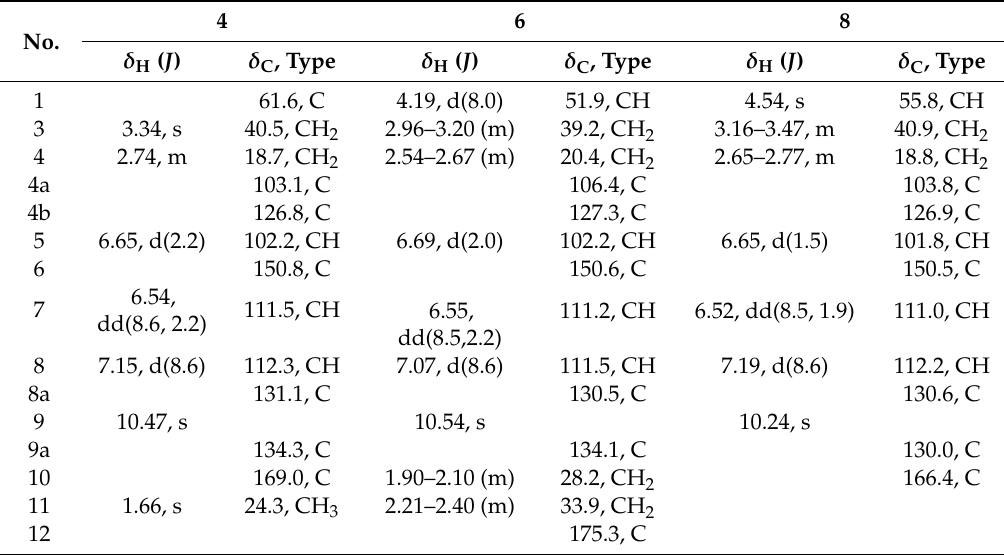
Table 2. 1 H-NMR, 13 C-NMR (600 / 150 MHz) spectroscopic data for 4 , 6 , and 8 in DMSO- d 6 , δ in ppm, J in